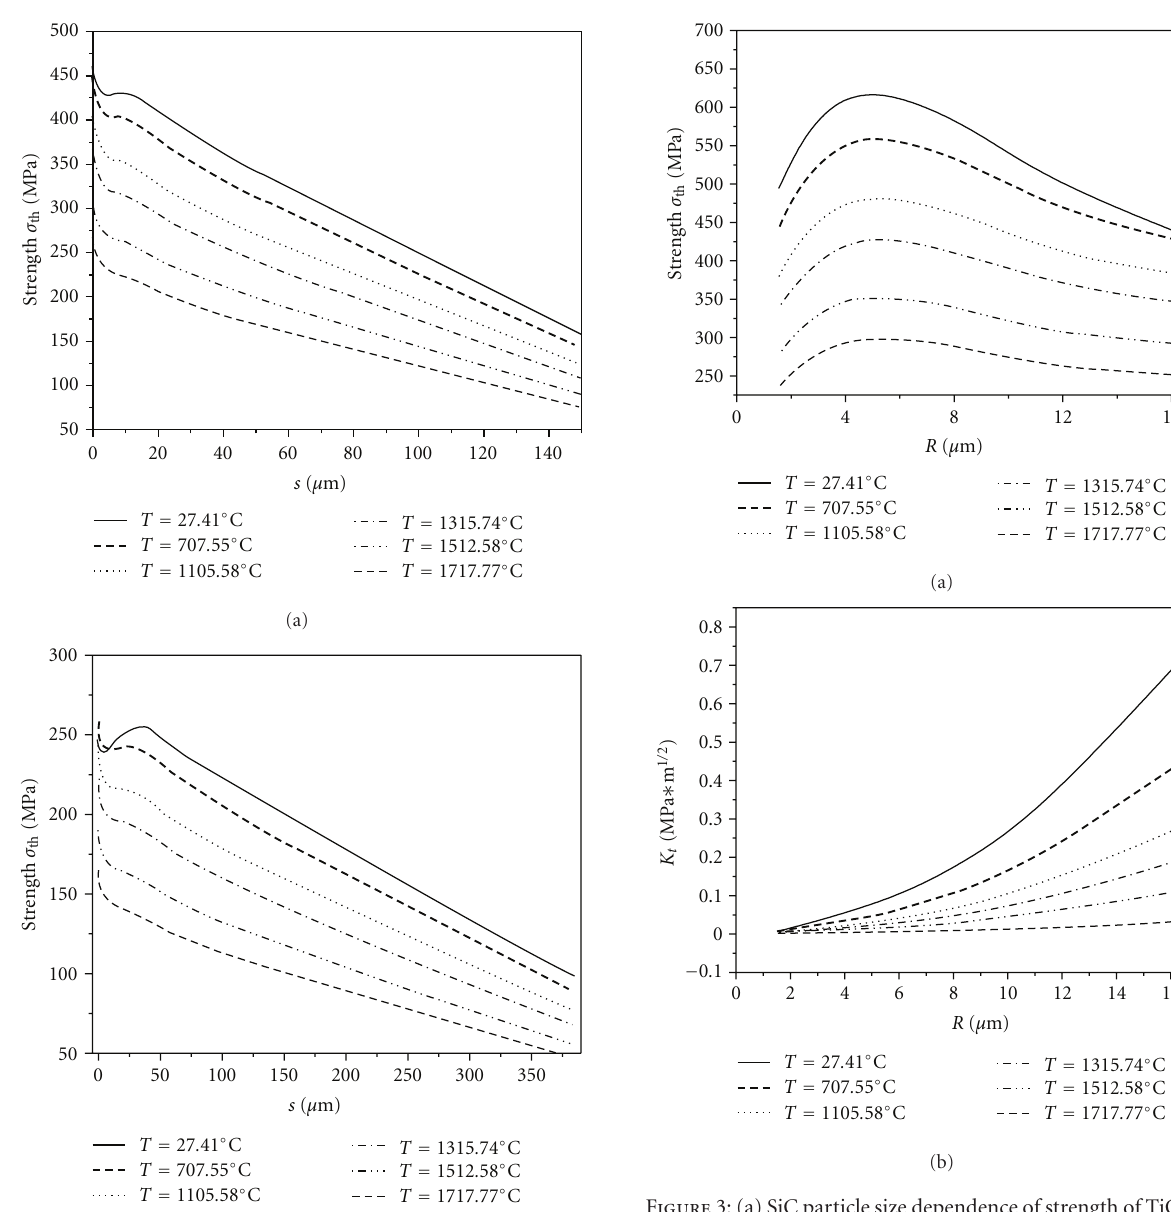
Figure 3: (a) SiC particle size dependence of strength of TiC-20 vol. % SiC at di ff erent temperatures ( R + s = 17 μ m). (b) SiC particle size dependence of the stress intensity factor due to the residual stress at di ff erent temperatures ( R + s = 17 μ